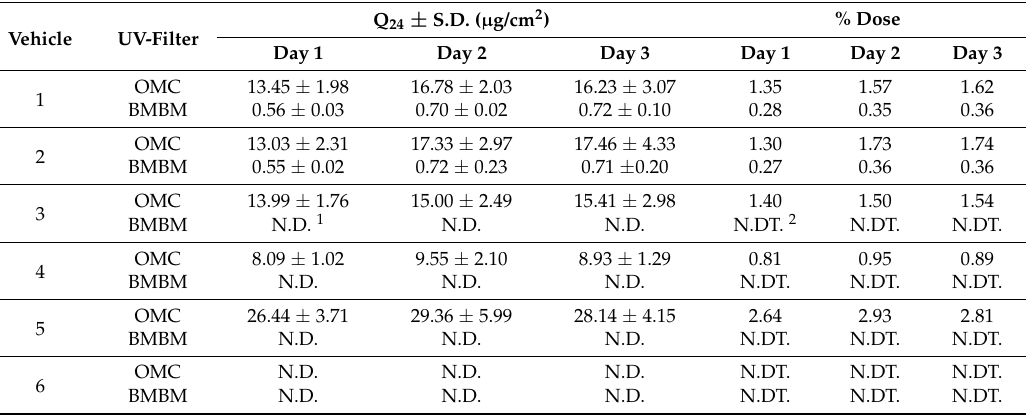
Table 7. In vitro skin permeation of OMC and BMBM from vehicle 1–6 after repeated applications for three consecutive days: cumulative amount permeated after 24 h (Q 24 ± S.D.) and percentage of dose permeated after 24 h (%